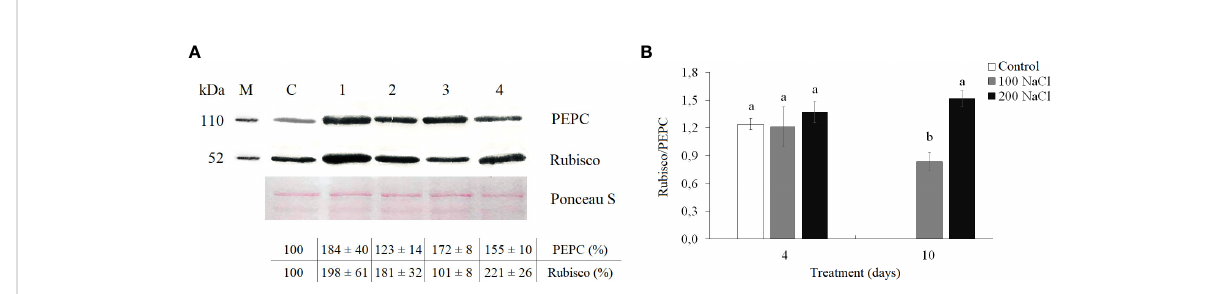
FIGURE 4 Effect of 4- and 10-day treatments with low (100 mM NaCl) and moderate (200 mM NaCl) salinity on Rubisco and PEPC contents in Kochia prostrata shoots. (A) Western blots for two key photosynthetic enzymes from total proteins extracted from shoots of Kochia prostrata . (B) Rubisco/PEPC ratio in Kochia prostrata shoots. Blots were probed with antibodies raised against Rubisco (subunit L) and PEPC. Numbers at the left indicate molecular mass in kilodaltons. M, marker; C, Control; 1, 4 days of 100 mM NaCl treatment; 2, 4 days of 200 mM NaCl treatment; 3, 10 days of 100 mM NaCl treatment; 4, 10 days of 200 mM NaCl treatment. Relative content of photosynthesis enzymes is shown on the basis of intensity of Western blotting bands estimated using ImageJ 1.37v software (United States) and expressed relative to average level for control plants taken as 100%. Equal protein loading was checked by staining of blots with Ponceau. Values are means ± standard errors of one experiment with three biological replicates. The different letters show statistically different means at P ≤ 0.05 (Tukey